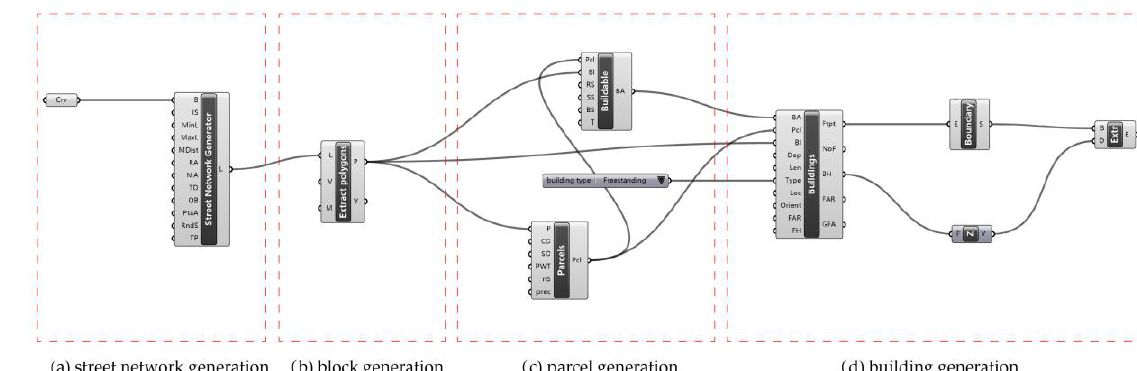
Buildings 2022 , 12 , x FOR PEER REVIEW Figure 3. The grasshopper components used in computational generation process. Figure 3. The grasshopper components used in computational generation process.